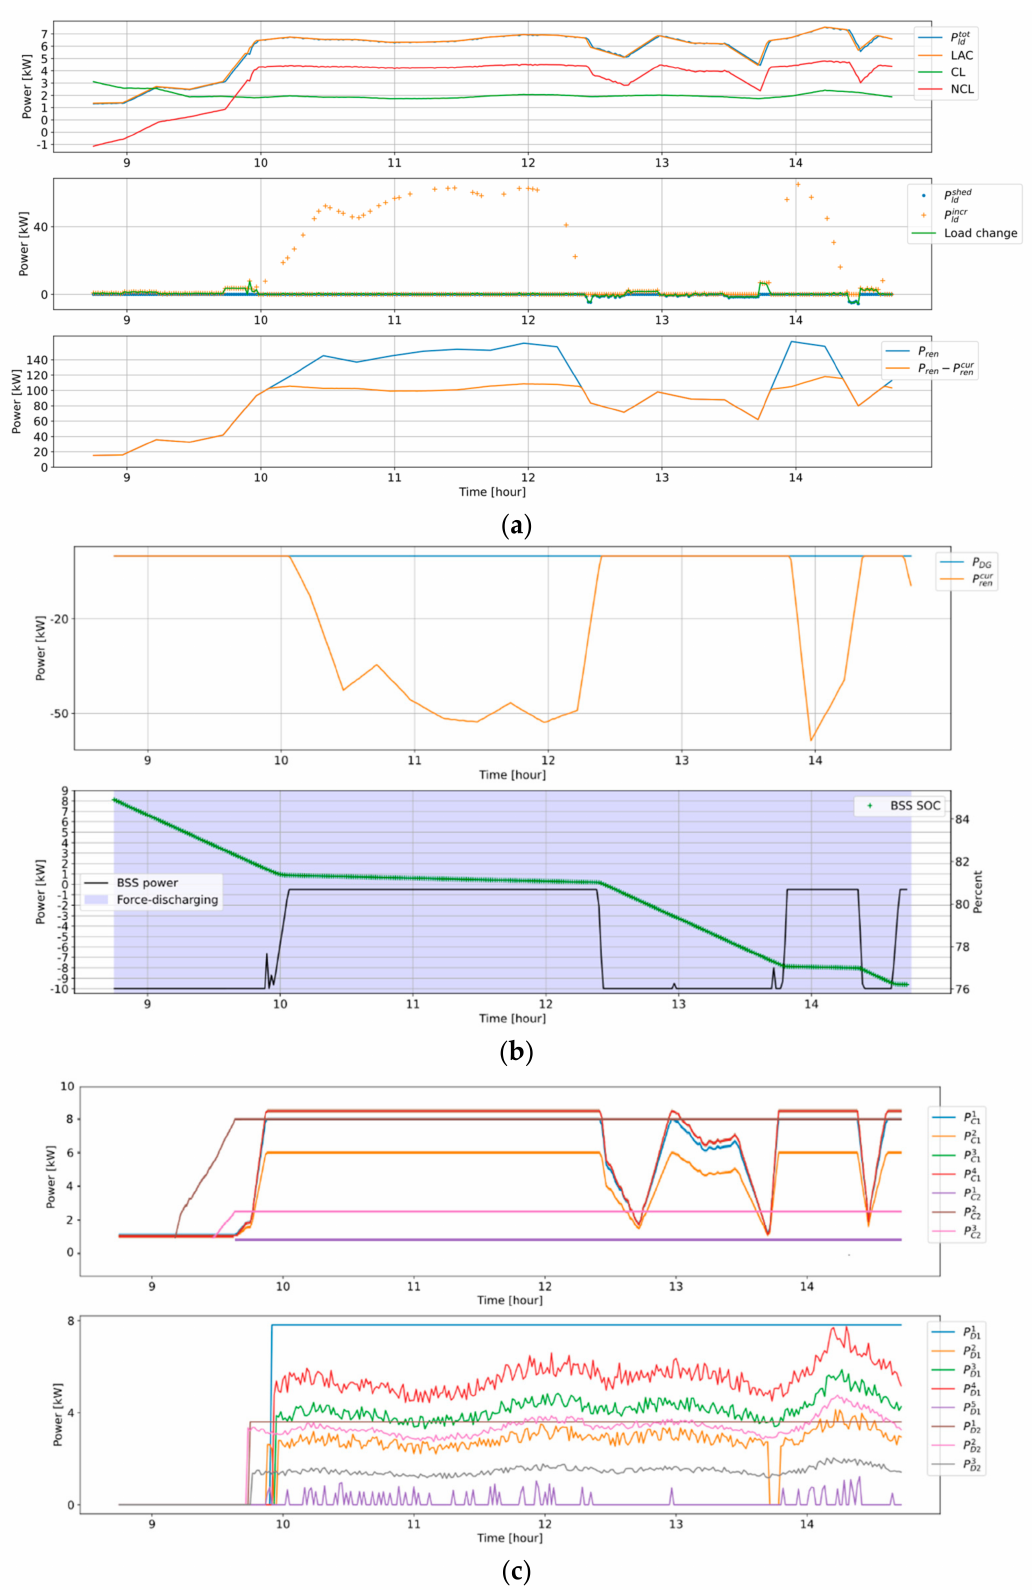
Figure 20. The results of Case-f: The DG is excluded from the system to test the dispatch function being generic. ( a ) Variation of the total load demand and PV generation. ( b ) Variation of the DG power output, curtailed PV generation, BSS SOC, BSS energy, and obtained dispatch rules during the test. ( c ) Illustration of power of individual DCLs and CCLs through the